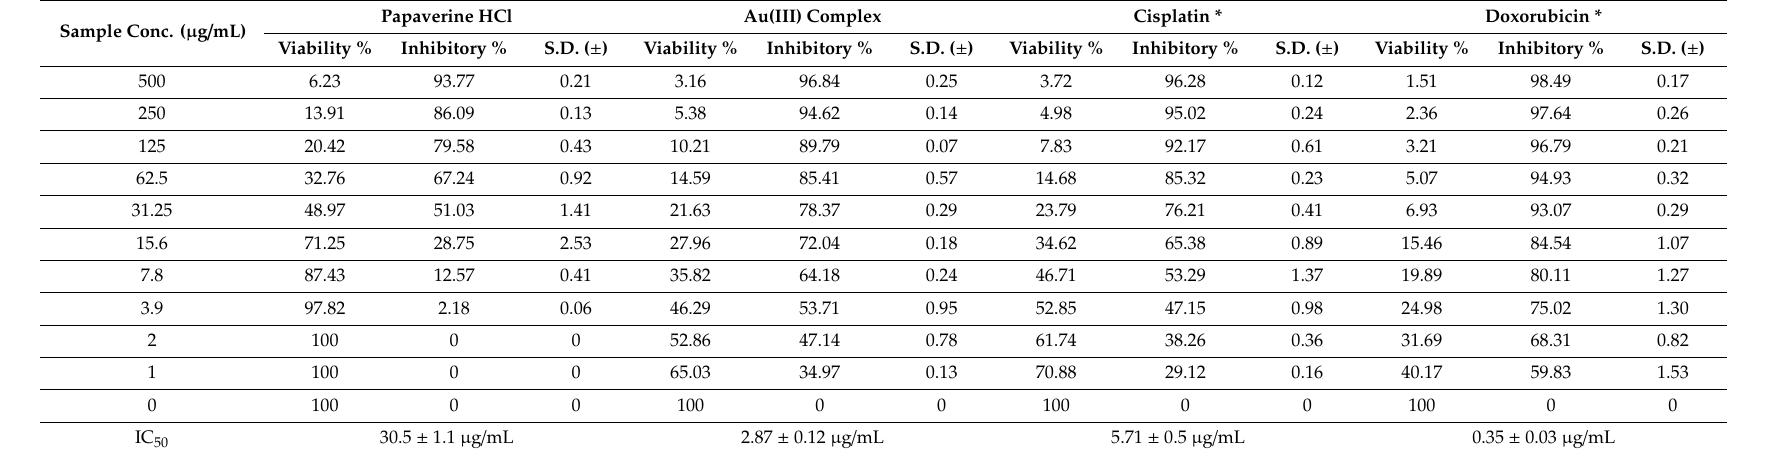
Table 7. The anticancer e ff ects of papaverine HCl and its Au(III) complex in human MCF-7